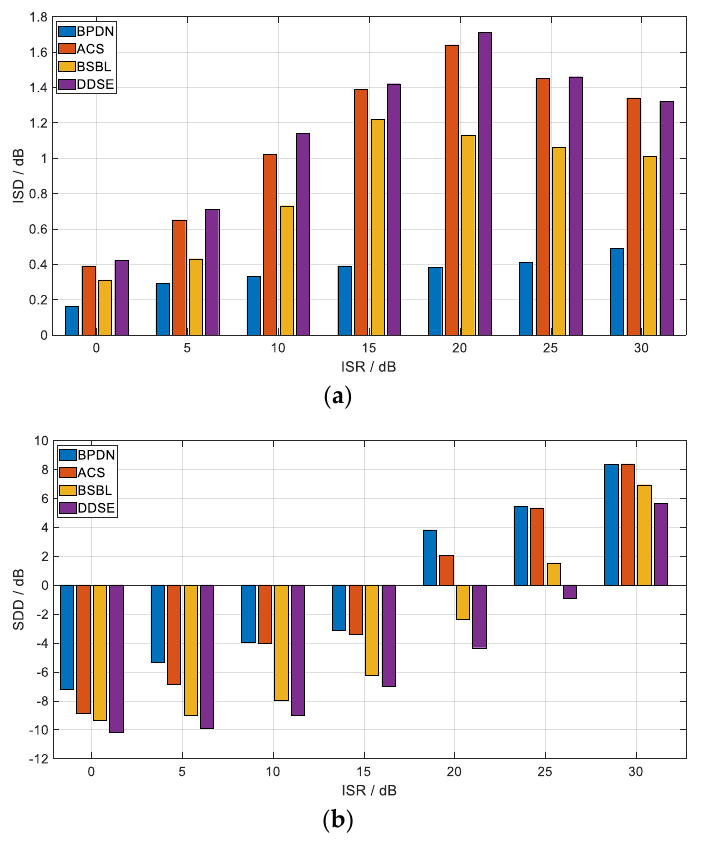
Figure 9. Signal reconstruction performance under different interference-to-signal ratio (ISRs). ( a ) interference suppression degree (ISD); ( b ) signal distortion degree (SDD). Table 2. ISDs under di ff erent sparsity levels and compression ratios (CR)